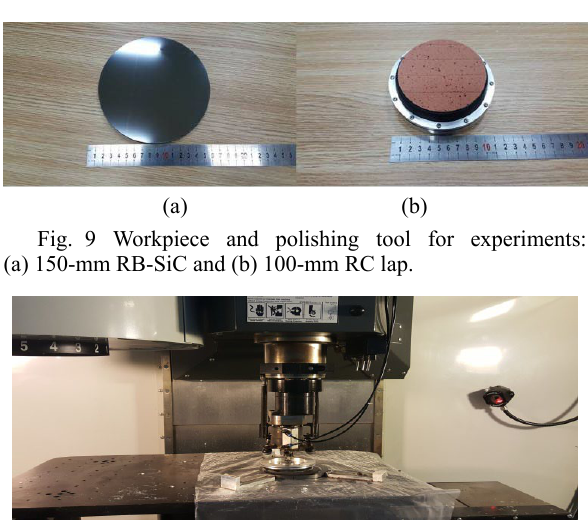
Fig. 10 CNC polishing machine used for experiments.